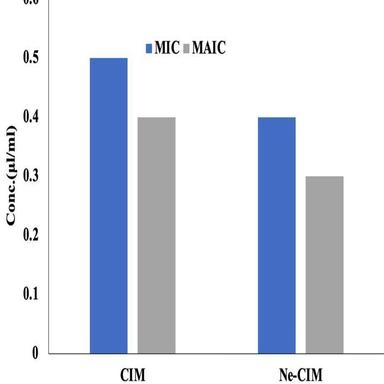
Comparative MIC and MAIC of CIM and Ne-CIM.